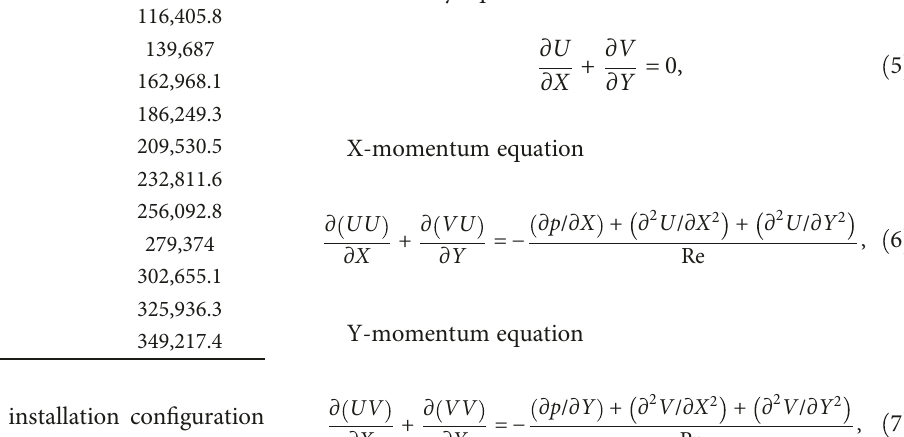
Table 2: Calculation of Reynolds number. Velocity